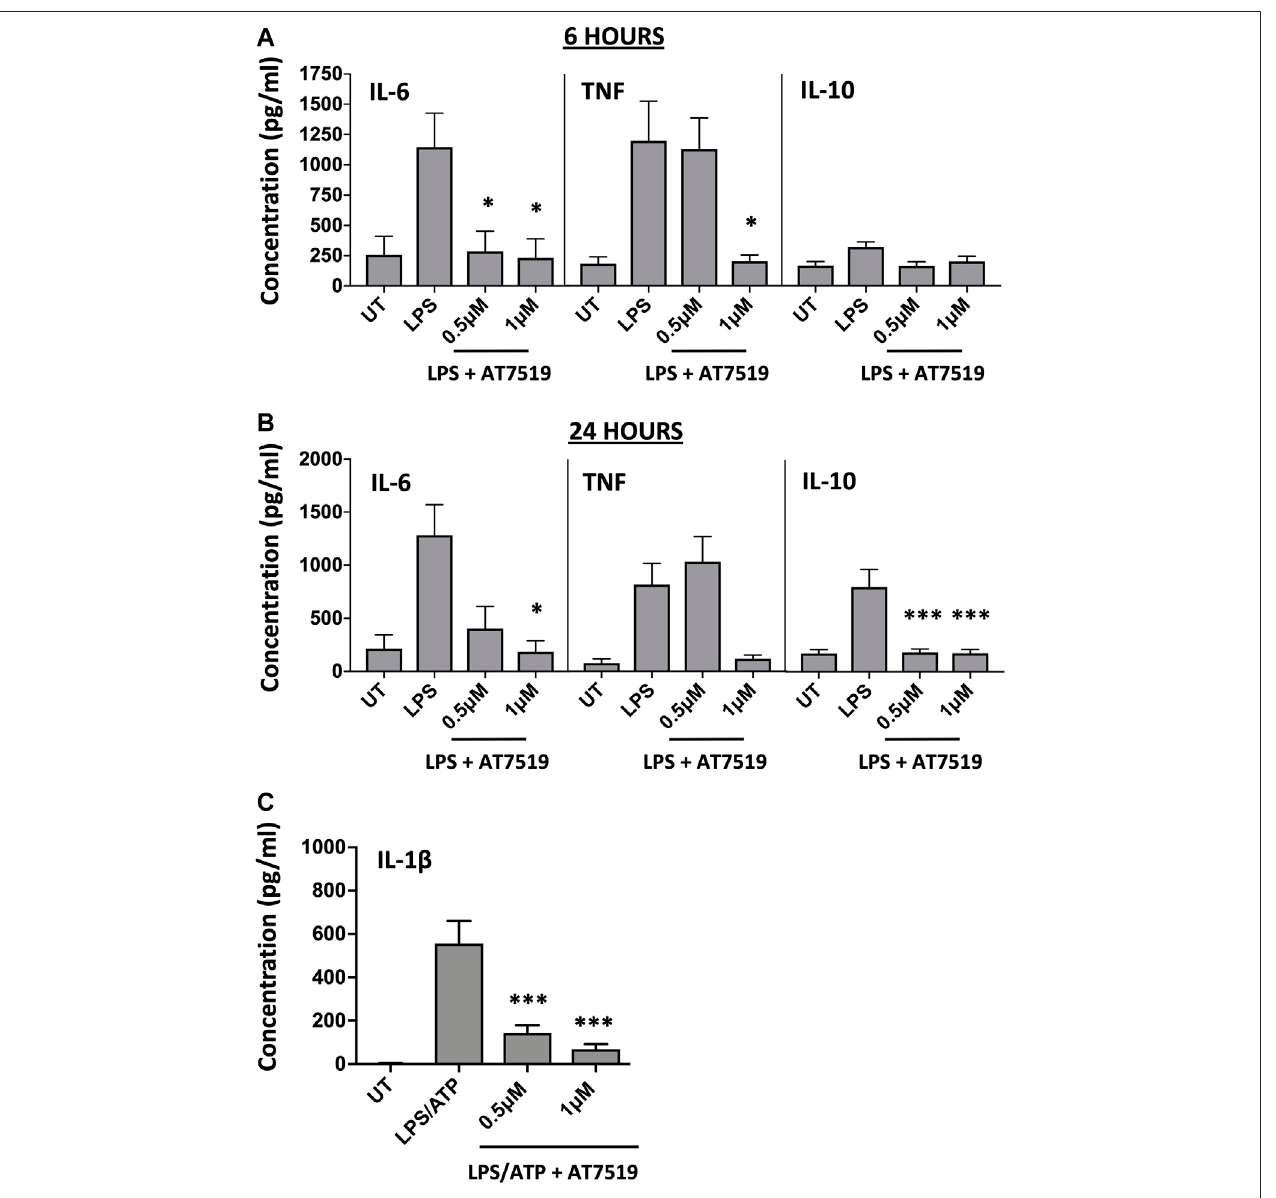
FIGURE 1 | Pharmacological inhibition of CDK9 with AT7519 attenuates LPS-induced pro-in fl ammatory cytokine release from human MDMs. Panels (A) and (B) IL-6, TNF and IL-10 cytokine release by MDMs untreated (UT) with AT7519 with or without LPS at either 6 h (A) or 24 h (B) . Data represent means ± SEM from n = 6 separate donors, * p < 0.05 ** p < 0.01 *** p < 0.001. (C) IL-1 β protein expression by MDMs pre-treated with AT7519 with or without 10 ng/ml LPS (3 h) and 5 mM ATP (1 h). Data represent means ± SEM from n = 3 separate donors, * p < 0.05 ** p < 0.01 *** p < 0.001.